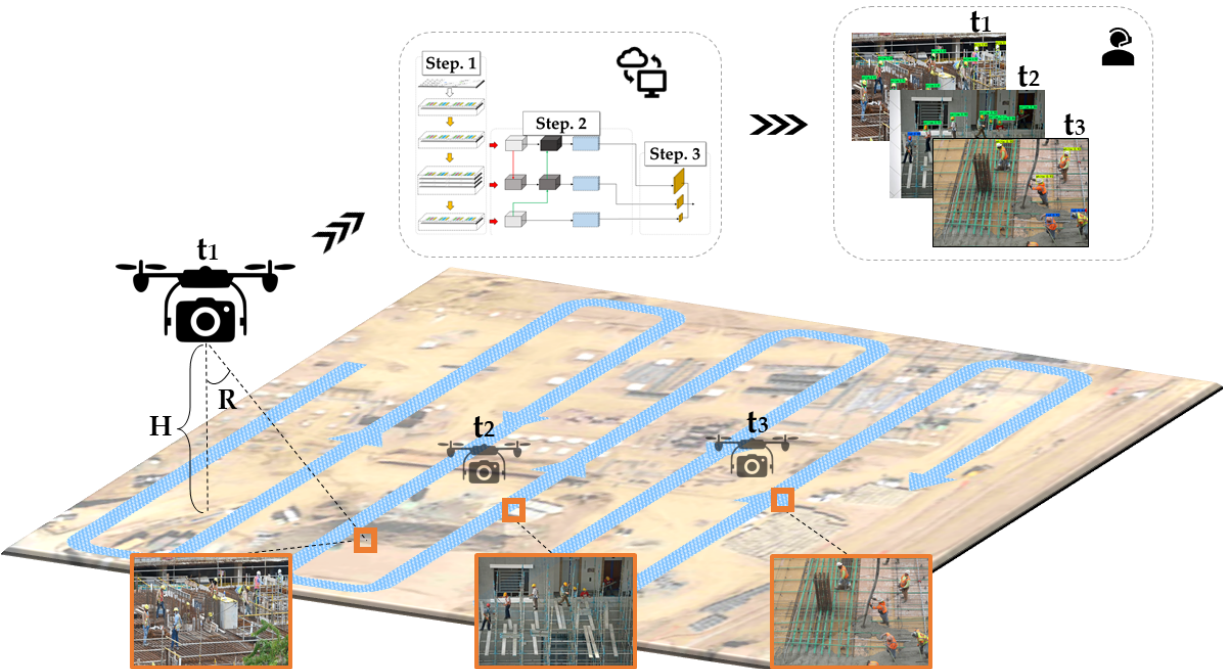
Figure 1. Flowchart of the proposed UAV low altitude remote sensing construction site patrol inspection system.